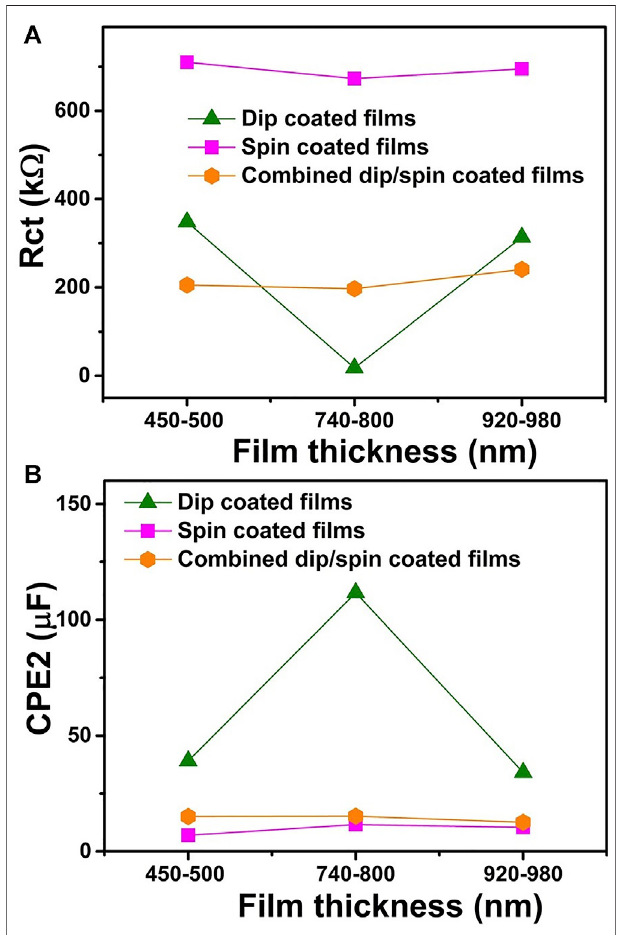
FIGURE 8 | (A) the charge transfer resistance (Rct) and (B) the surface states capacitance (CPE2) for fi lms of various thicknesses prepared using different coating methods respectively, for EIS measurements performed under light